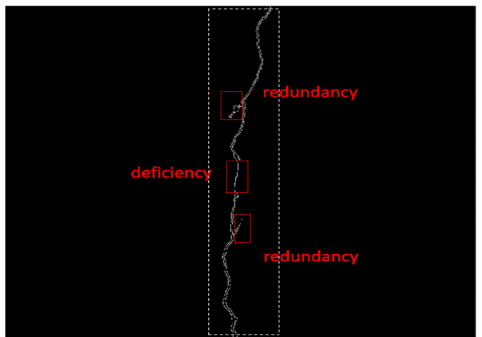
Figure 9. Double edge skeleton